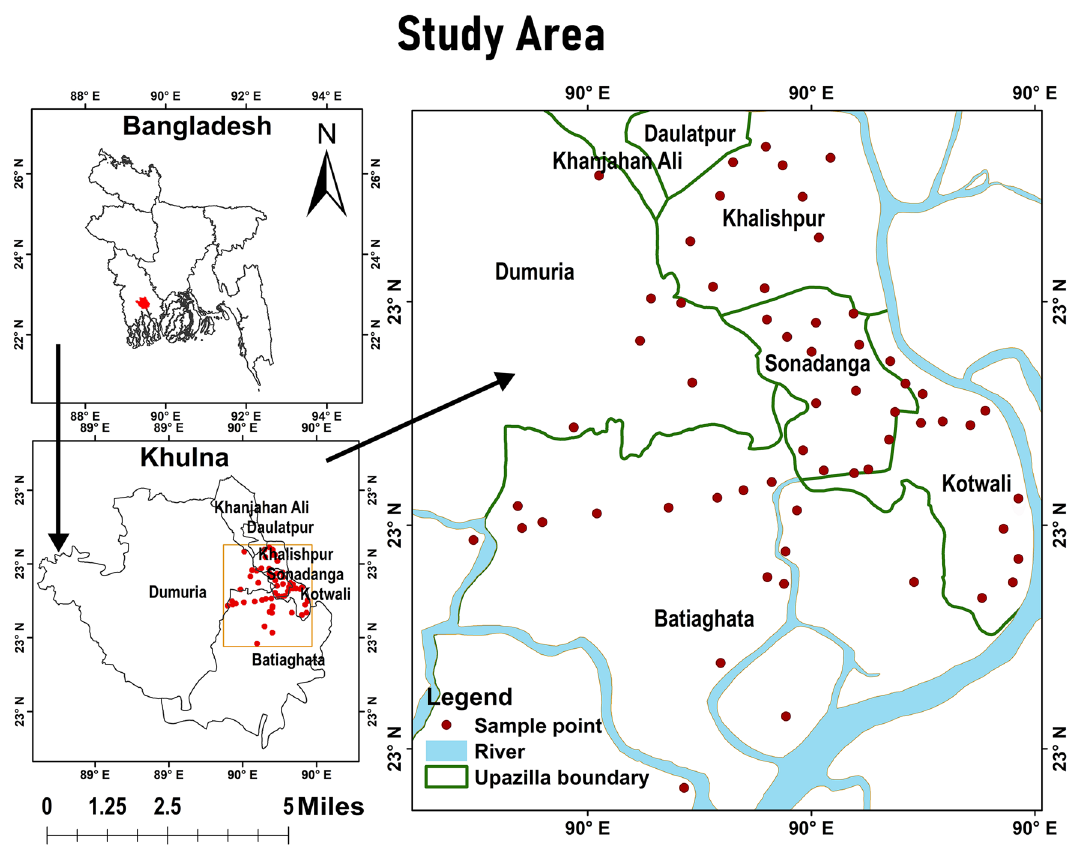
Fig. 1 The sampling locations of the study